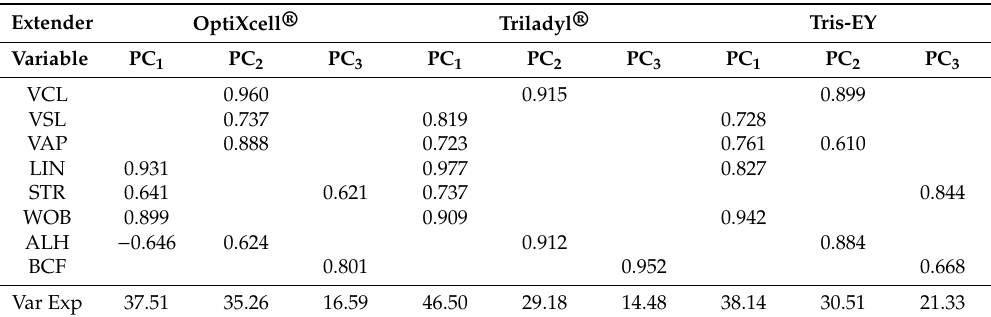
Table 2. Eigenvectors of principal components (PCs) * for kinematic variables of bull sperm in three commercial